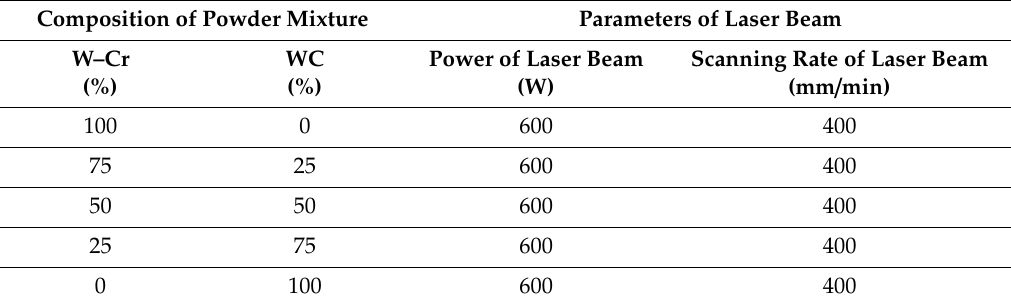
Figure 1. Scheme of laser processing. Table 2. Parameters of laser processing.